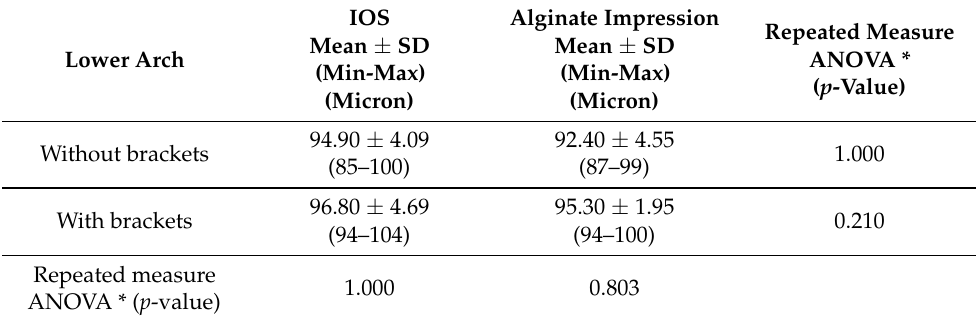
Table 4. Average surface deviation (mean difference and standard deviation) in measurements by IOS, alginate, and control in the lower